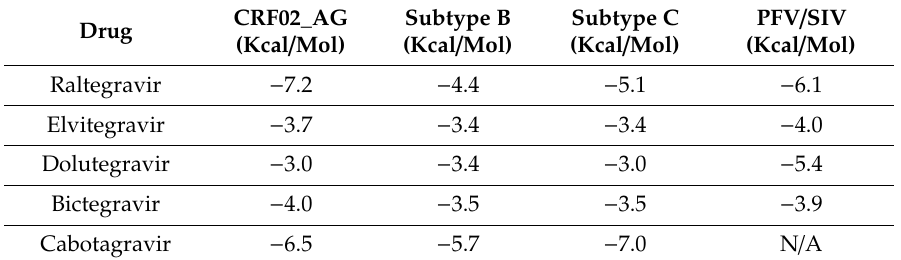
Figure 3. Linear relationship between the predicted binding constants calculated from the docking studies of integrase strand transfer inhibitors (INSTI) with HIV Ins and the experimental half-maximal e ff ective concentration (EC50) values determined from the TZM-bl cells-based assay. Table 1. Vinardo binding a ffi nity scores predicted for each INSTI bound to the three IN subtypes CRF02_AG, B, and C and the PFV / SIV reported INs.